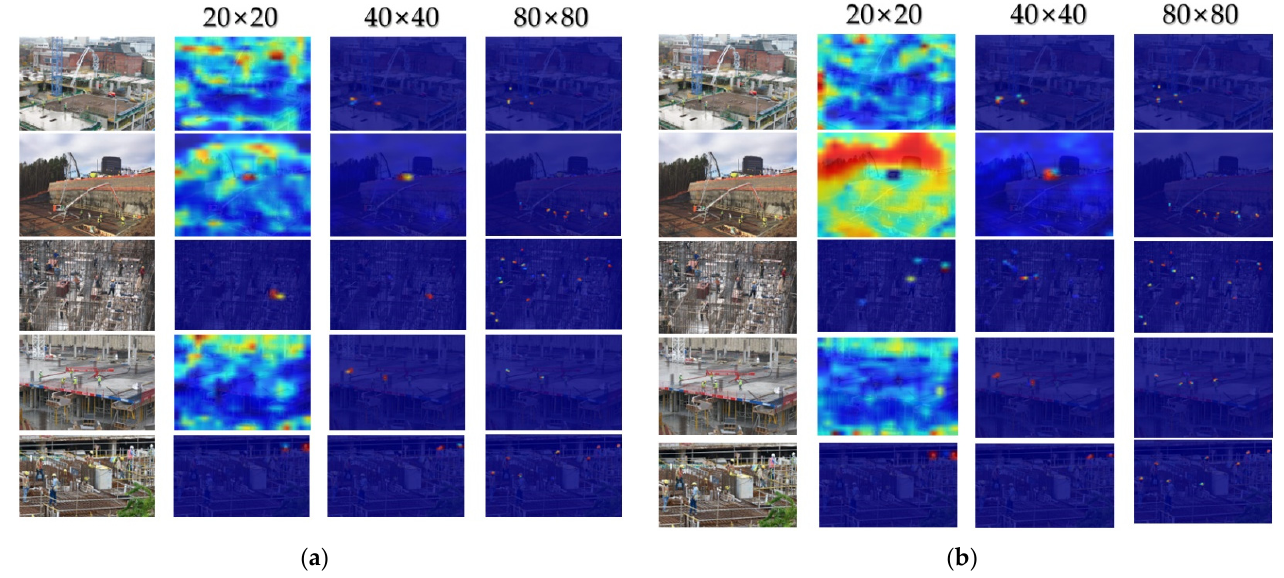
Figure 14. The visualized heat map generated by the LRCAv3 proposed in this paper is configured at the Attention locations shown in Figure 4, respectively, where higher colors indicate higher weights given by the network. ( a ) No Attention module is configured, and ( b ) LRCAv3 is configured.